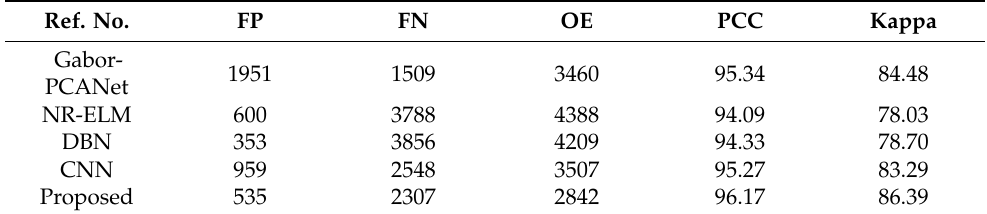
Table 7. Change detection results of the Farmland D dataset Ref. No.